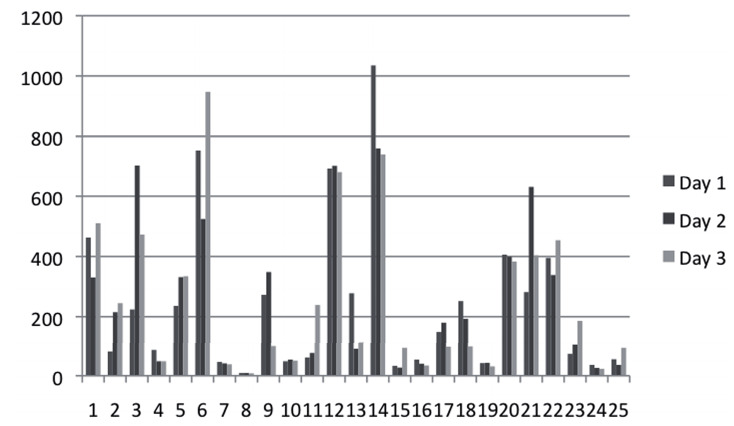
figure 1 - Three day 24-hour pad weights.